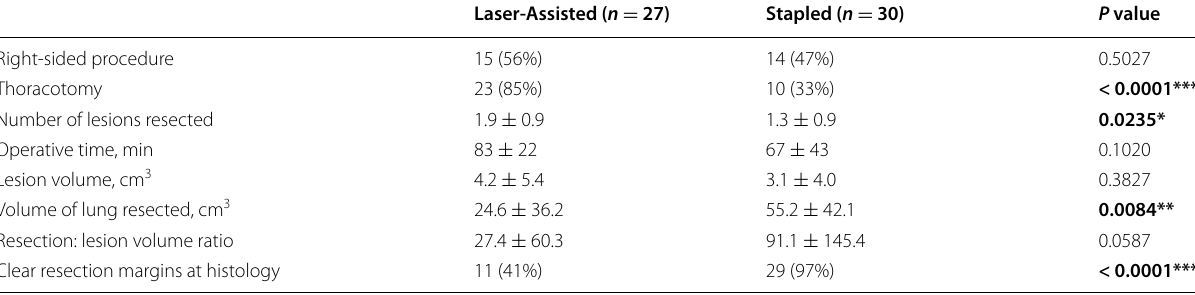
Table 3 Operative characteristics